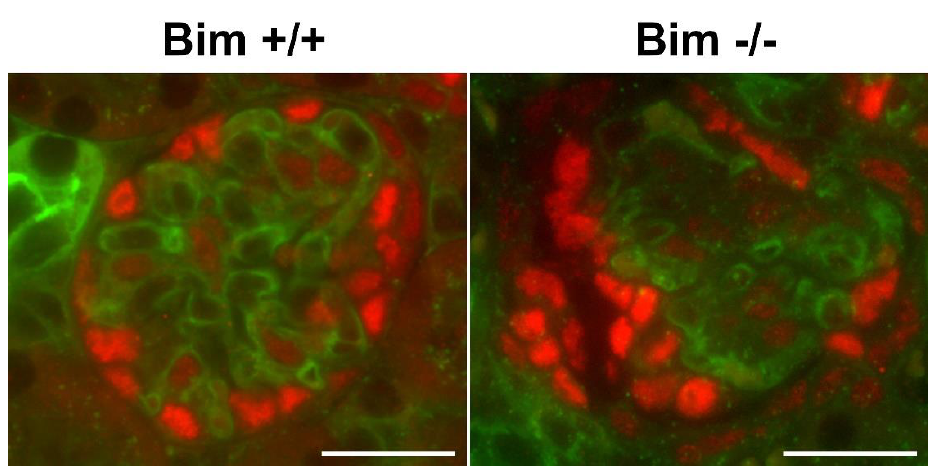
Figure 4. Glomular collapse in kidneys from P21 Bim −/− mice. Kidneys from P21 mice were stained with WT-1(red) to stain podocytes and Lycopersicon esculentum (green) to stain the vasculature. Data is representative of six mice. Scale bar is 100 µm.